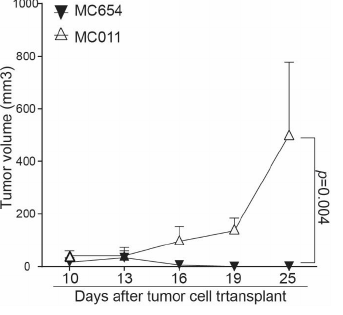
Figure 5. Deletion of Irf8 gene in tumor cells promotes tumor growth in vivo. WT MC654 and IRF8 KO MC011 cells were injected into C57BL/6 mice (5 ×10 5 cells/mouse). Tumor growth was monitored over time.